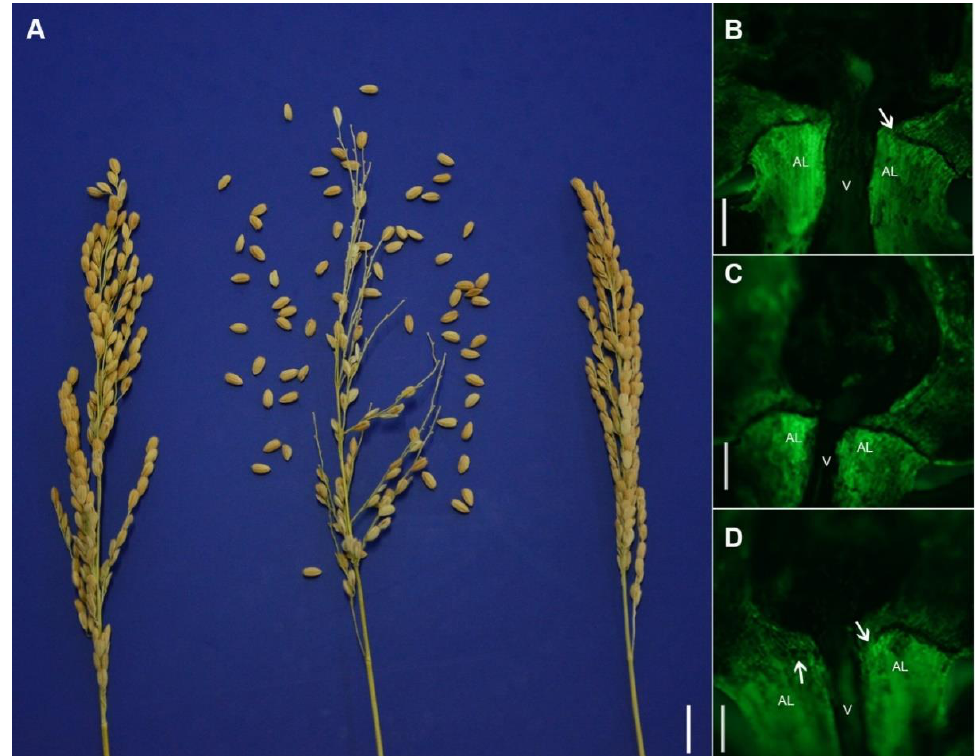
Figure 1. ( A ) The seed shattering rate of Yundao 1 (left), F 1 hybrid (middle) and near-isogenic line (NIL- hs1 ) (right). Scale bars = 0.5 cm. ( B–D ) Fluorescence images of a longitudinal section of the spikelet and pedicel junction in Yundao 1, F 1 hybrid and NIL- hs1 , respectively. ( B ) Yundao 1 showed an incomplete in abscission zone. ( C ) F 1 hybrid with a complete abscission layer. ( D ) NIL- hs1 exhibited a deficiency in abscission layer on the palea side and partial abscission layer on the lemma